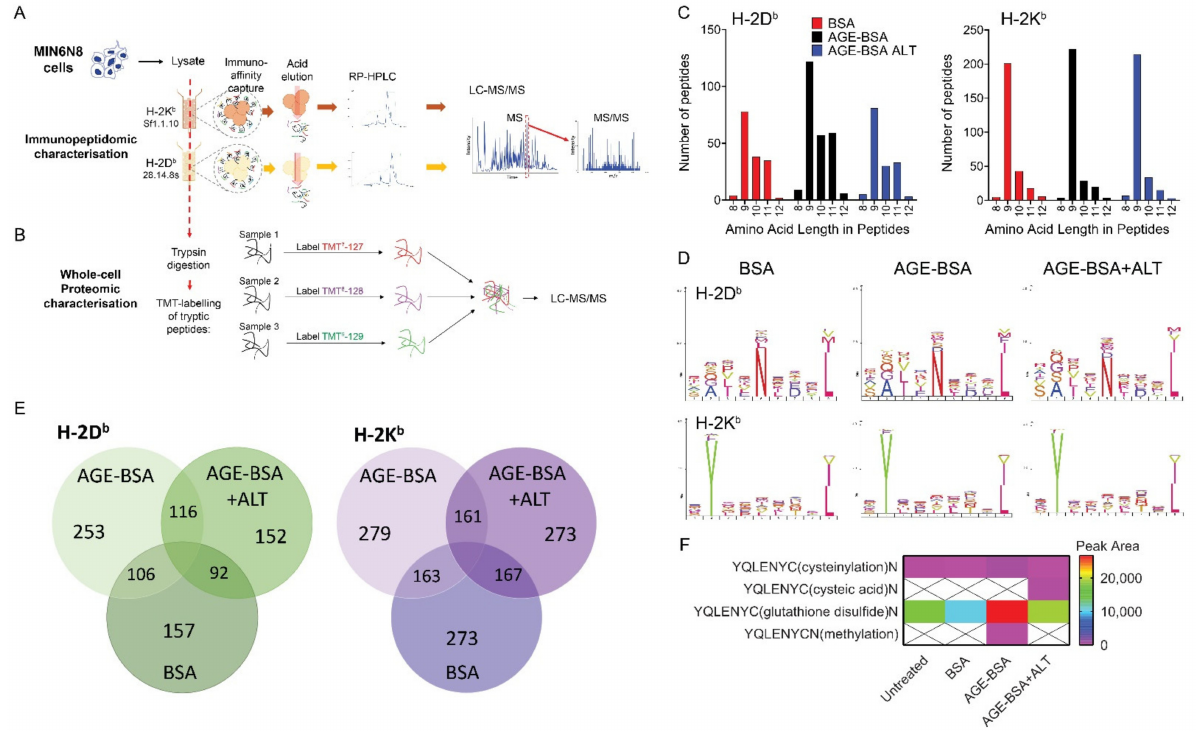
Figure 4. Immunopeptidomic and whole-cell proteomic characterisation of murine NOD β -cells. NOD ShiLt derived MIN6N8 β -cells were treated overnight with unmodified BSA (BSA; 100 µ g/mL), AGE-modified BSA (AGE-BSA; 100 µ g/mL), with or without alagebrium chloride (AGE-BSA+ALT; 40 µ M) or untreated, with ALT vehicle control (PBS) or with BSA+ALT (Figures S7 and S8). Pooled cells (total 2 × 10 7 cells, pooled from n = 4175 cm 2 tissue culture flasks) from each treatment were lysed and antibodies against MHC Class 1a H-2K b (clone sf1.1.10) and H-2D b (clone 28.14.8 s) used to capture and identify presented peptides. Peptide complexes were run on RP-HPLC and identified via LC-MS/MS. Schematic of ( A ) immunopeptidomic and ( B ) whole-cell proteomic workflow used. ( C ) Number and length of MHC Class 1a H-2D b (left) and H-2K b (right) captured peptides isolated from BSA (red), AGE-BSA (black) and AGE-BSA+ALT (blue) treated MIN6N8 cells. ( D ) MHC Class Ia bound amino acid motifs of H-2D b (top) and H-2K b (bottom) peptides isolated. ( E ) Number of common H-2D b (green; left) and H-2K b (purple; right) immunocaptured MHC Class Ia associated peptides. ( F ) Modifications of insulin peptides precipitated with MHC Class Ia H-2D b antibody from MIN6N8 cells. Scale bar shows peak